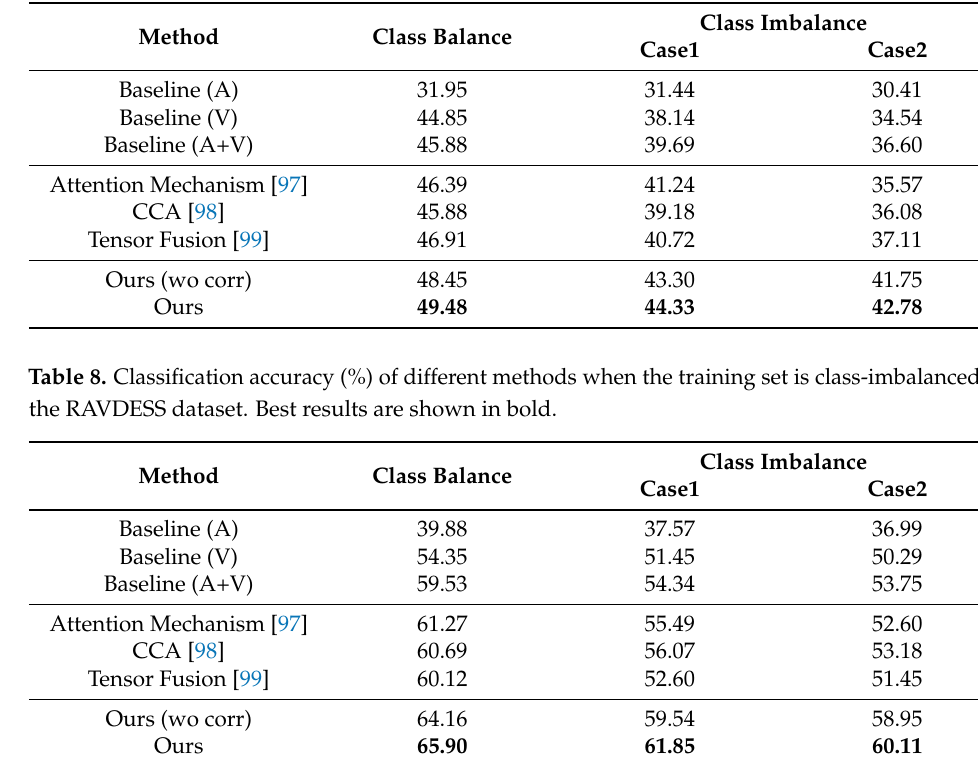
Table 7. Classification accuracy (%) of different methods when the training set is class-imbalanced on the eNTERFACE’05 dataset. Best results are shown in bold.